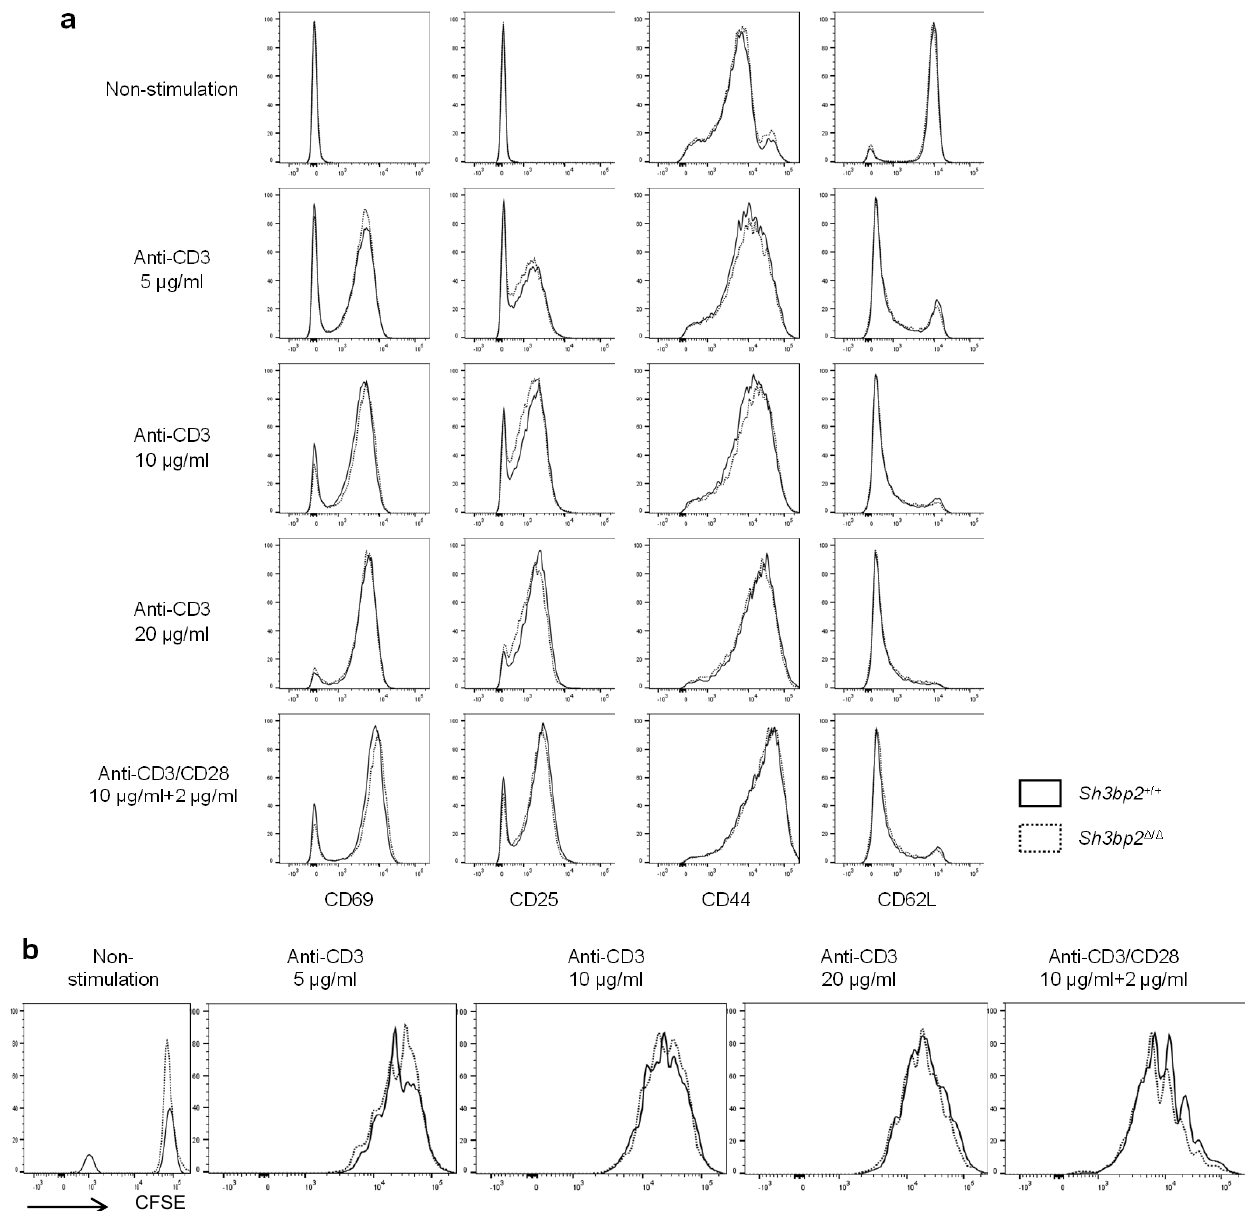
Figure A5. SH3BP2 deficiency does not affect the in vitro activation and proliferation of CD4 + T cells. ( a ) Flow cytometry analyses for cell surface protein expression on CD4 + T cells. Isolated CD4 + T cells were stimulated with immobilized anti-CD3/anti-CD28 at indicated concentrations for 24 h. ( b ) In vitro proliferation of CD4 + T cells was measured by CFSE dilution at 72 h upon stimulation (anti-CD3 and anti-CD28 antibodies). Representative flow cytometry histograms are shown. CFSE, carboxyfluorescein succinimidyl